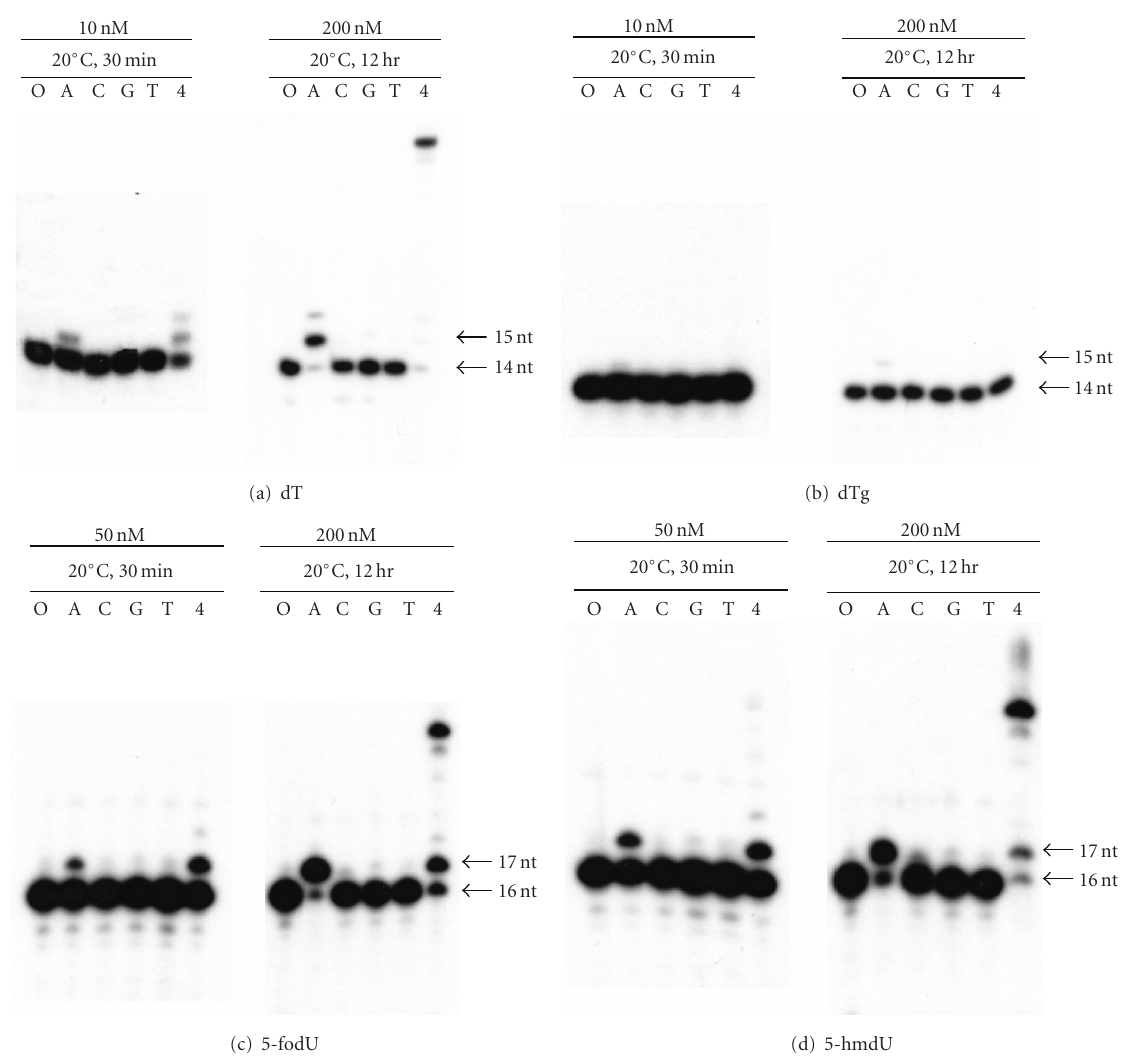
Figure 2: Primer extension assay for Pol IV to bypass dTg, 5-fodU, and 5-hmdU in the template oligonucleotides. Primers were labeled at the 5 (cid:4) -terminal by polynucleotide kinase and annealed with appropriate template oligonucleotide. Primer/templates (50fmol) in a 10- μ l reaction mixture was incubated at 20 ◦ C with purified Pol IV at 50 nM for 30min (left) and at 200nM for 12hr (right), followed by polyacrylamide gel electrophoresis. (a) dT (primer 1/template 8), (b) dTg (primer 1/template 9), (c) 5-fodU (primer 2/template 6), and (d) 5-hmdU (primer 2/template